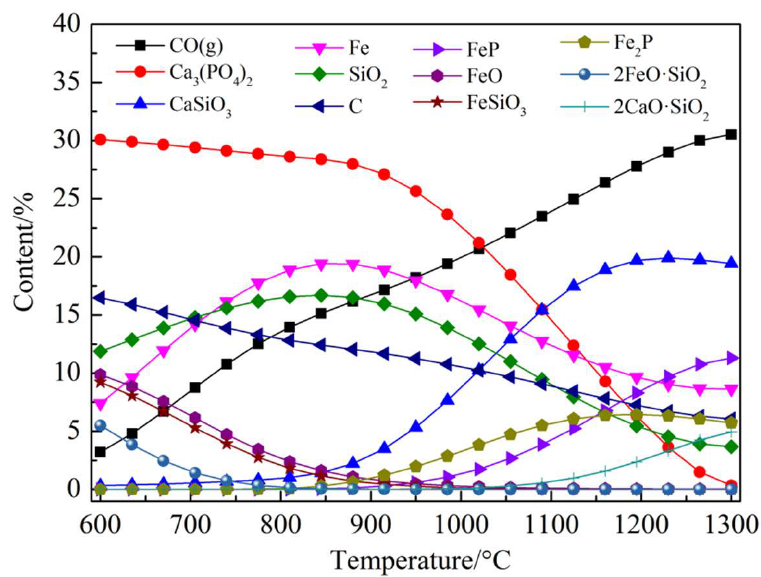
Figure 7. Thermodynamic equilibrium composition in the Ca 3 (PO 4 ) 2 –C–Fe 2 O 3 –SiO 2 system.